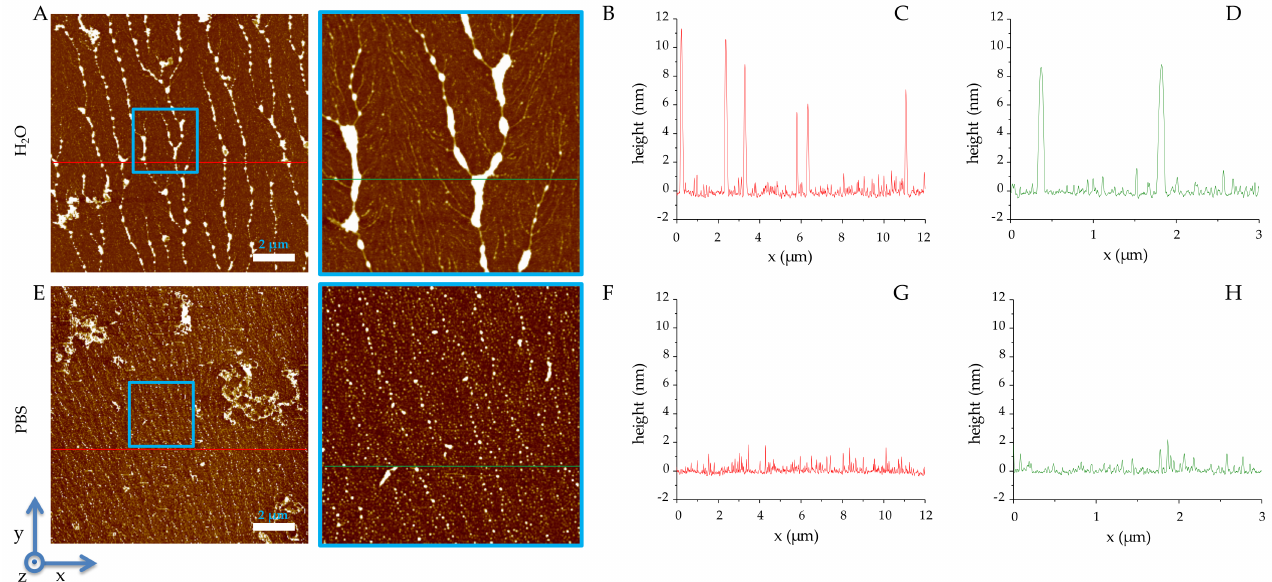
Figure 2. AFM images of 1018-K6. ( A ) 12 µ m × 12 µ m field image of dried water solution of RiLK1, the scale bar is 2 µ m, the blue square locates the 3 µ m × 3 µ m field reported in image ( B ); heights referred to by the red line in ( A ) are reported in graph line in ( C ) and heights referred to by the green line in (B) are reported in graph line in ( D ); ( E ) 12 µ m × 12 µ m field image of dried PBS solution of RiLK1, the scale bar is 2 µ m, the blue square locates the 3 µ m × 3 µ m field reported in image ( F ); heights referred to by the red line in ( E ) are reported in graph line in ( G ) and heights referred to by the green line in ( F ) are reported in graph line in ( H